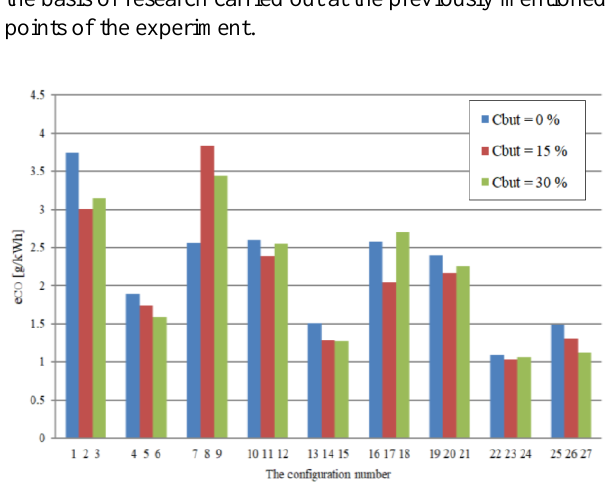
Fig. 5. Comparison of the specific CO emission for the engine fed with blend n-butanol fuel and MDF